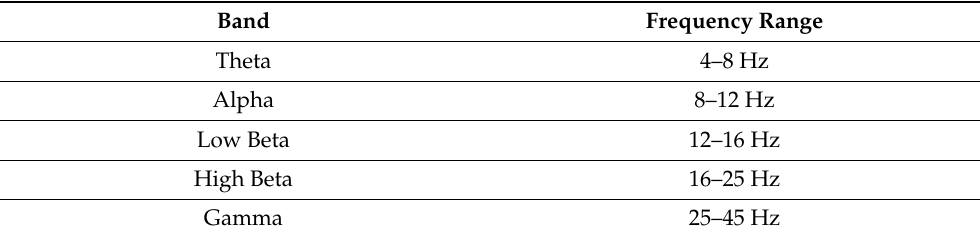
Table 3. Frequency range of used sub-bands.